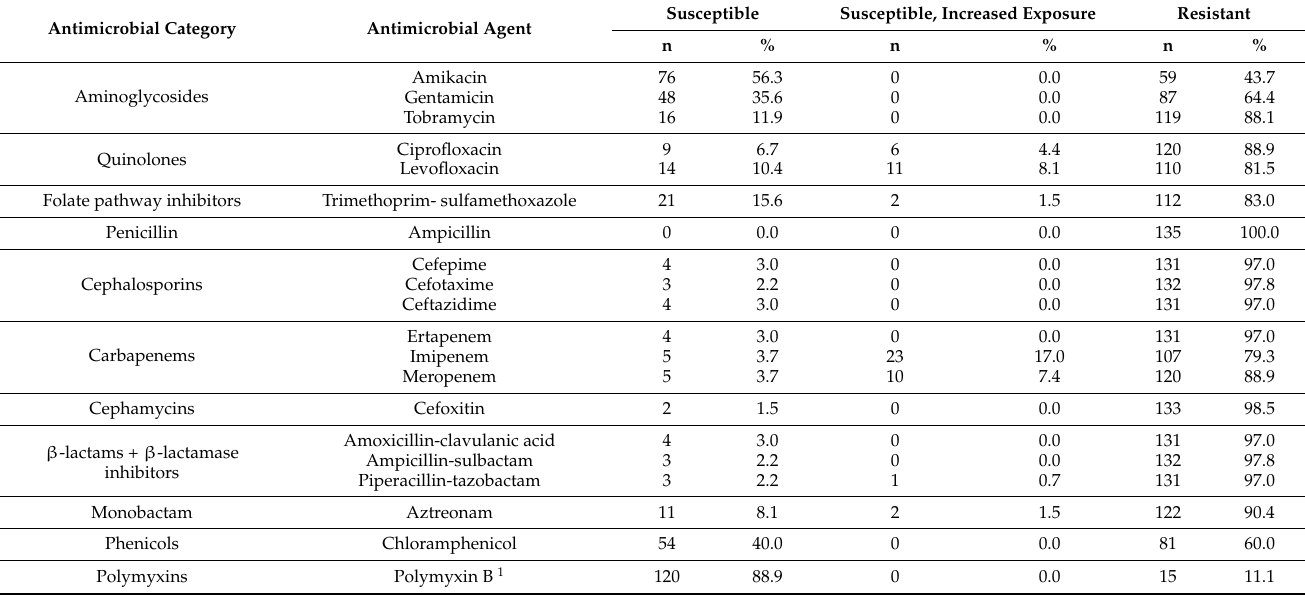
Table 1. Antimicrobial susceptibility of NDM-producing Klebsiella species from Brazil (n = 135). Antimicrobial Category Antimicrobial Agent